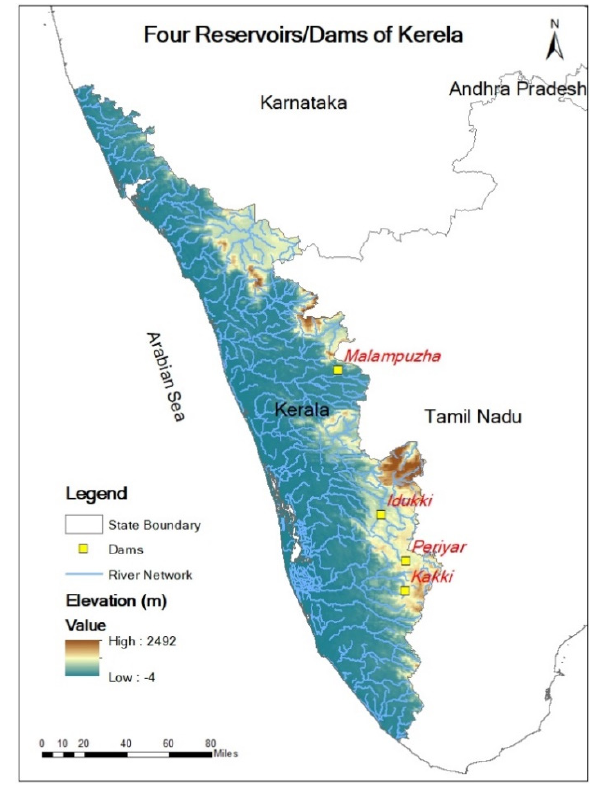
Figure 10. Thenetwork of rivers, the elevation of the coastal region, and the location of four major reservoirs/dams in Kerala.